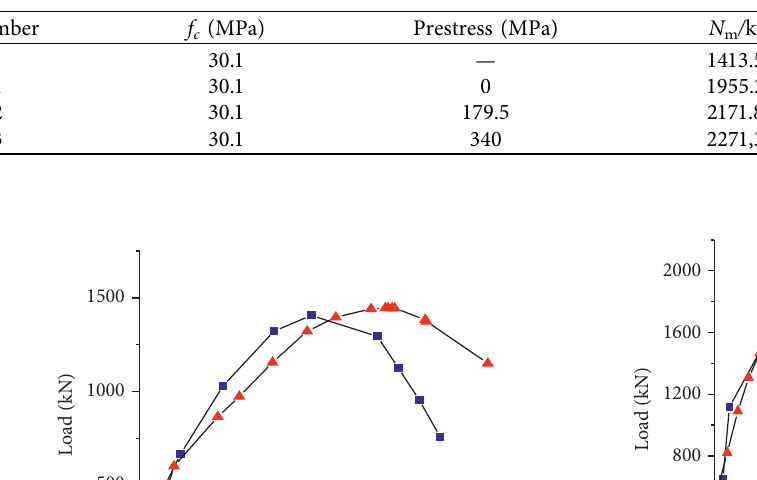
Table 4: Comparison of experimental and calculated